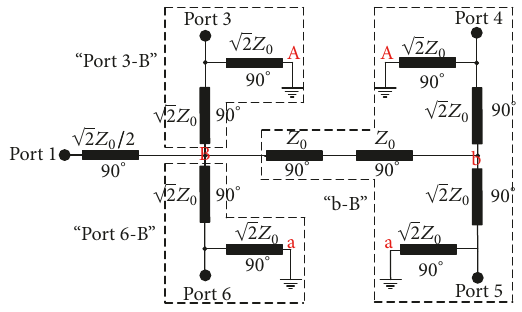
Figure 3: Equivalent structure of the hybrid feeding network with Port 1